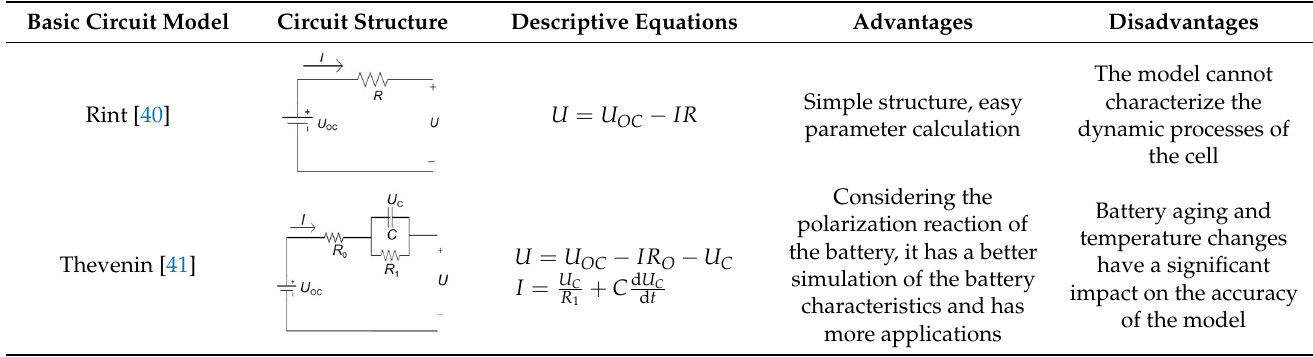
Table 1. Comparison of commonly used equivalent circuit models.